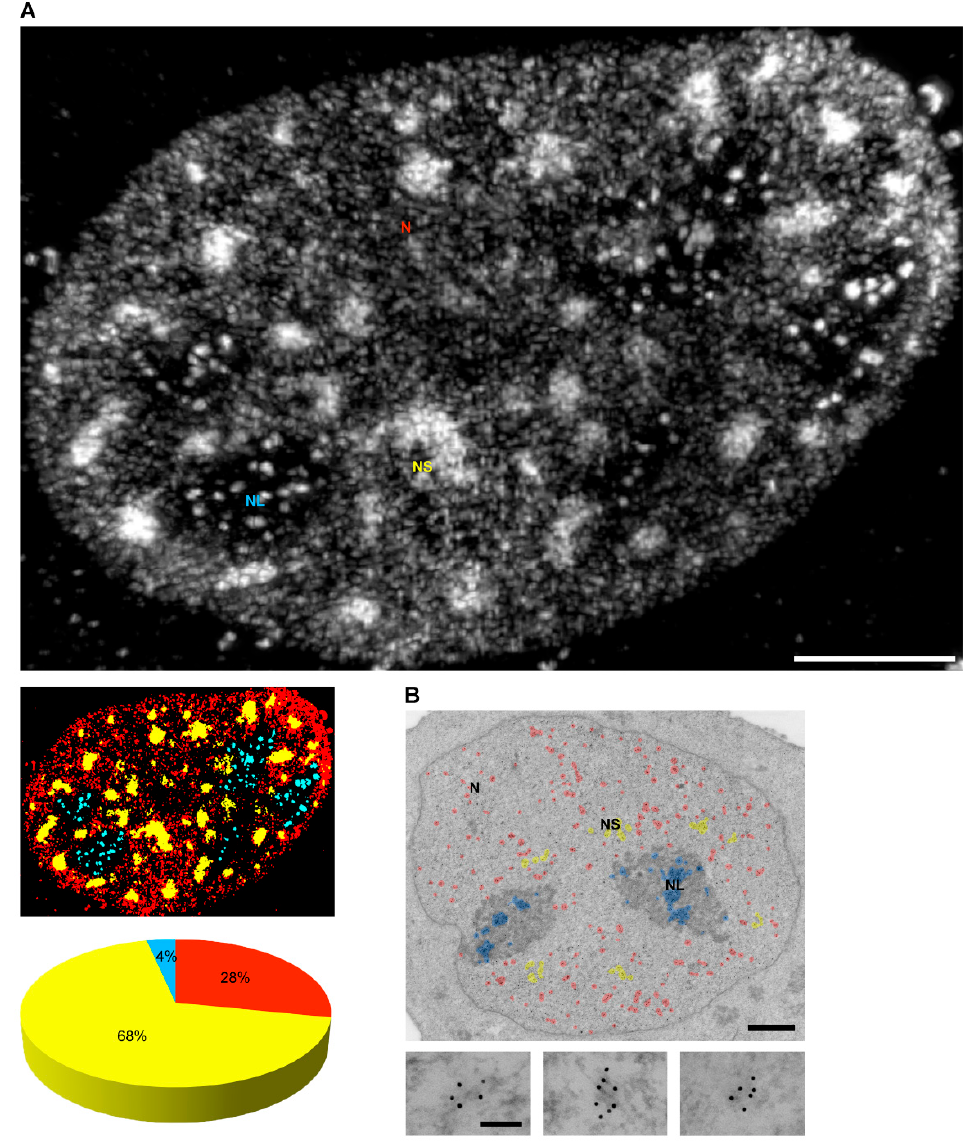
Figure 2. Nuclear lipid islets (NLIs)—a recently described nuclear compartment involved in RNA polymerase II (pol II)-dependent transcription. ( A ) Using super-resolution three-dimensional structured illumination microscopy (3D SIM), we revealed NLIs in the nucleoplasm as small foci labeled by anti-phosphatidylinositol 4,5-bisphosphate (PI(4,5)P2) antibody. Nuclear PI(4,5)P2 labeling reconstructed in 3D is presented here as a two-dimensional (2D) maximum intensity projection image. Using the NIS-Elements and MATLAB software, we determined the relative distribution of PI(4,5)P2 in nuclear speckles, nucleoli, and NLIs. The color-coded image and diagram presented below show PI(4,5)P2 in nuclear speckles in yellow, PI(4,5)P2 in NLIs in red, and the nucleolar PI(4,5)P2 in blue. ( B ) Transmission electron microscopy (TEM) demonstrates the localization of nuclear PI(4,5)P2 labeling in full detail. Color-coding is the same as in ( A ). NLIs of 40–100 nm are presented below in magnified view. Abbreviations in ( A ) and ( B ): N—nucleus, NL—nucleoli, NLIs—nuclear lipid islets, NS—nuclear speckles. The bars in ( A ) and ( B , general view) are 1 µ m; the bar in ( B , magnified views) is 100 nm. Figure 2 is presented here with permission from Sobol et al. [75].